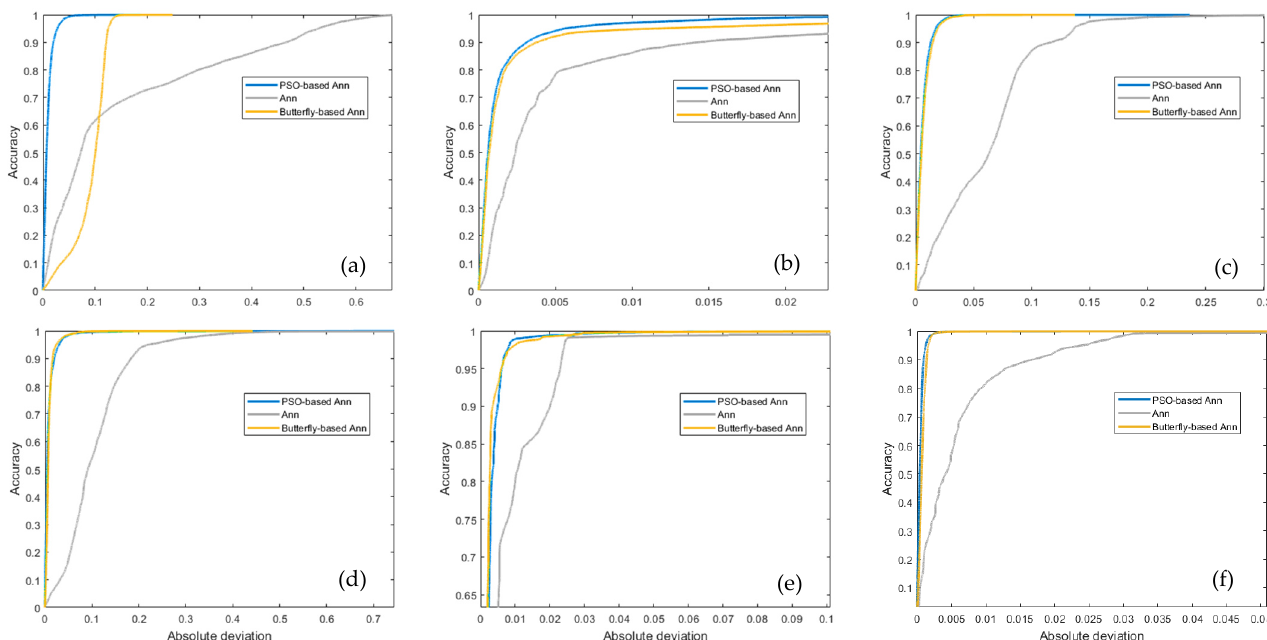
Figure 11. REC curves for the ANN-BR, PSO-ANN, and BOA-ANN for ( a ) HWS 1 ( b ) HWS 2 ( c ) HWS 3 ( d ) HWS 4 ( e ) HWS 5 ( f ) HWS 6 at 1.5 m depth.